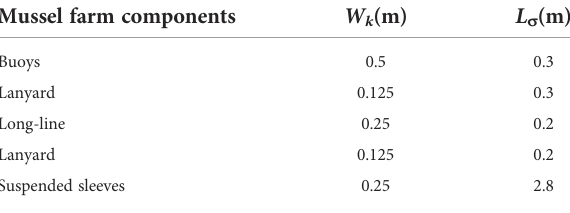
TABLE 1 Geometric parameters of the aquaculture facility components.